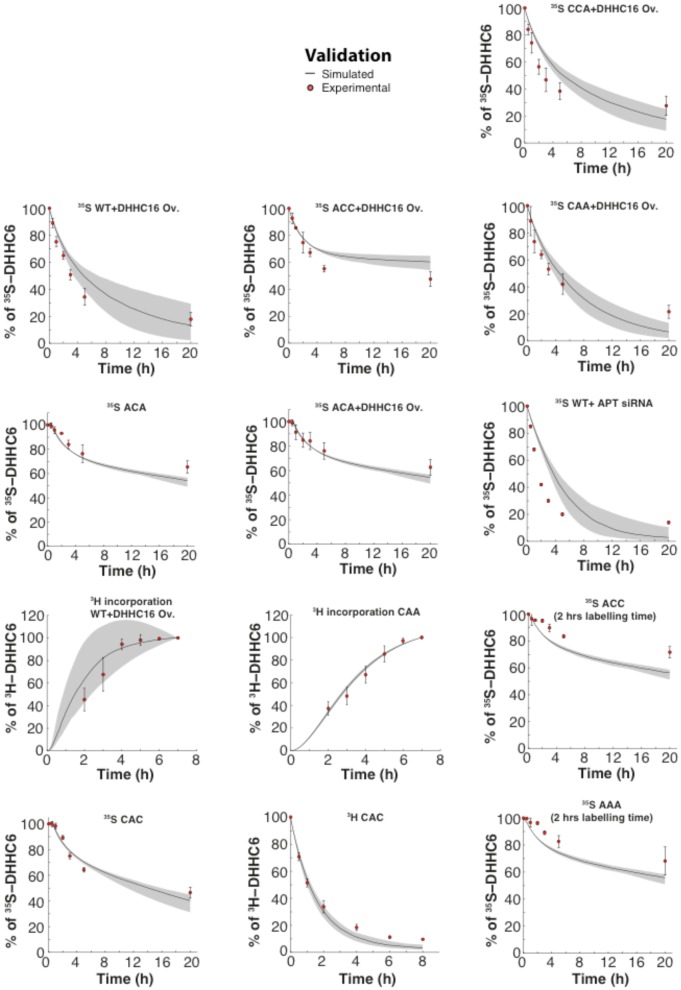
Validation.Results of the GA optimization are plotted on top of the experimental data used as validation.